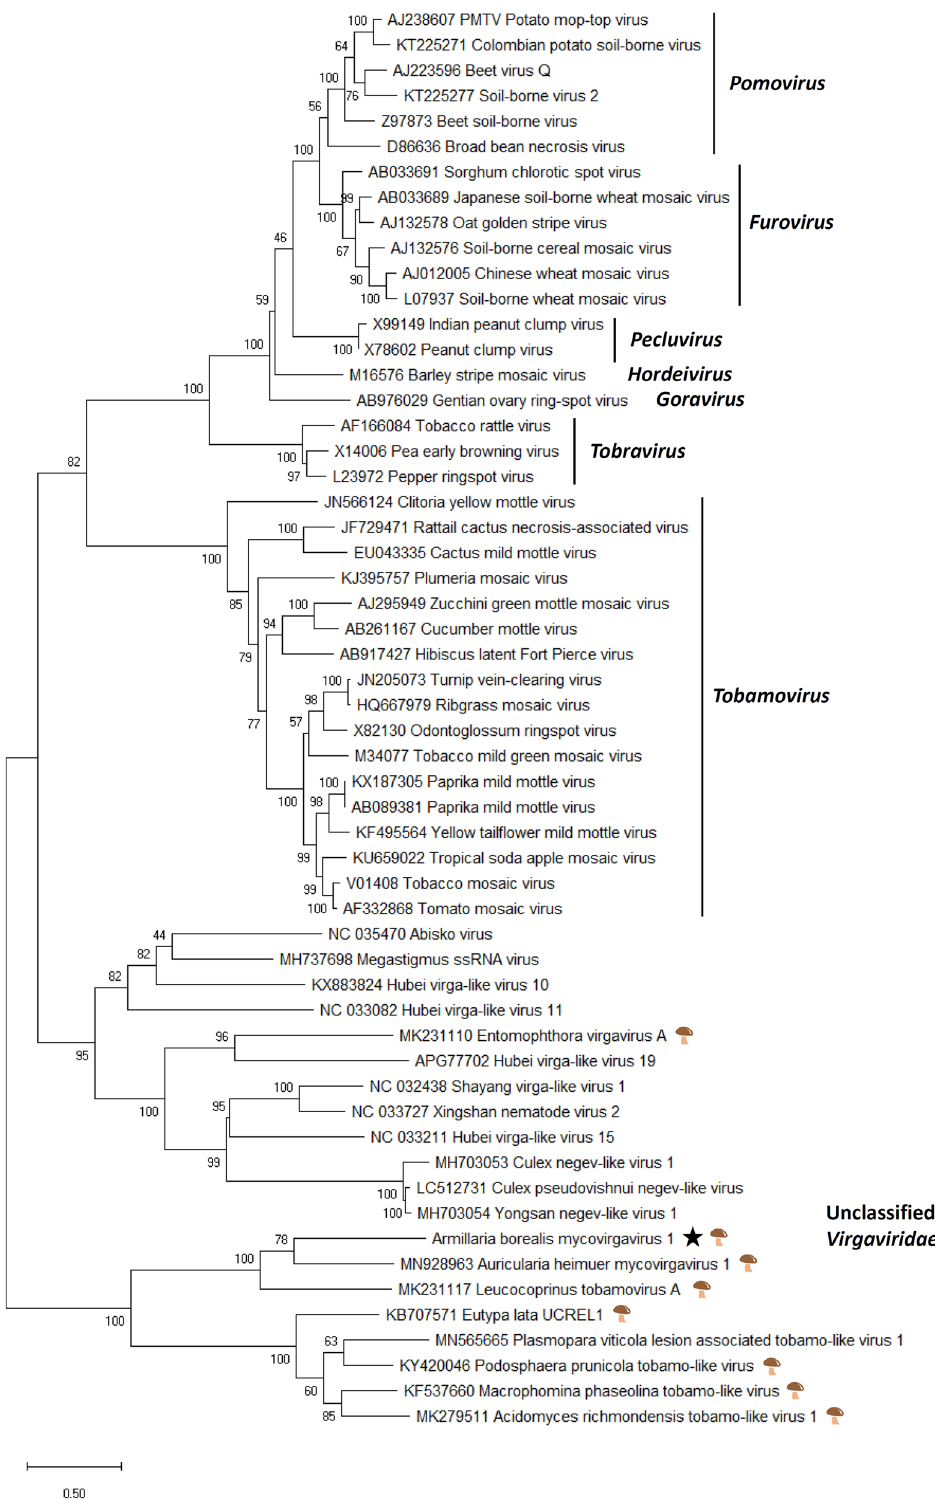
Figure 2. Phylogenetic tree of the family Virgaviridae and related unclassified viruses based on an alignment of RdRP aa sequences generated using MAFFT v7.450 with Blosum45 substitution matrix. The evolutionary history was inferred by using the Maximum Likelihood method and Le_Gascuel_2008 model with 4 gamma categories (+ G + I ). All positions with less than 95% site coverage were eliminated, i.e., fewer than 5% alignment gaps, missing data, and ambiguous bases were allowed at any position. Evolutionary analyses were conducted in MEGA X with 1000 bootstrap repeats 86 . Sequences originating from fungal hosts are indicated with a mushroom symbol and a star denotes the Armillaria